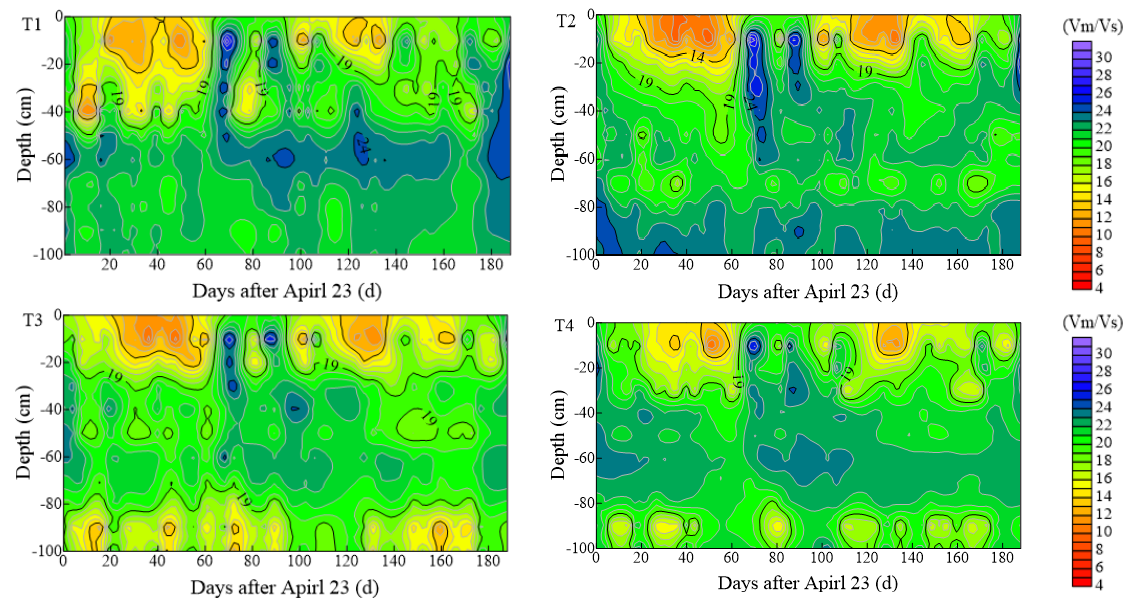
Figure 2. The spatiotemporal distribution of soil moisture between rows and between trees within the row in 2015. ( − 20 indicates 20 cm below the ground).